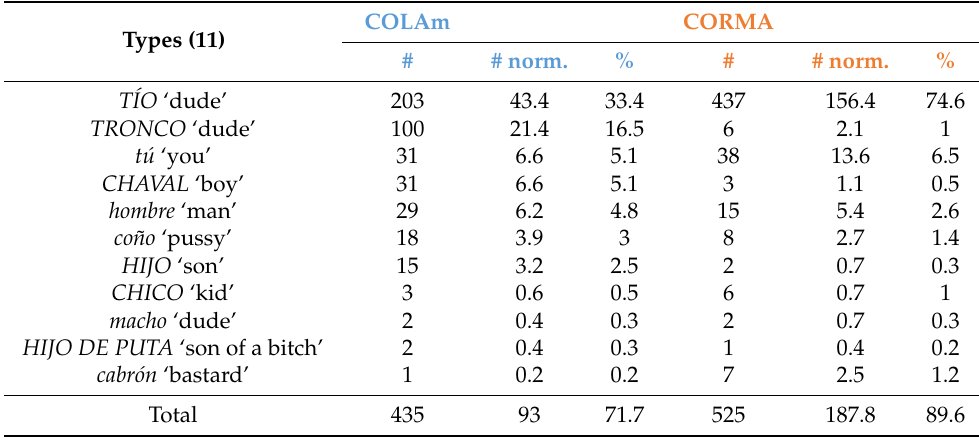
Table 7. Comparison of vocative types occurring in both COLAm and